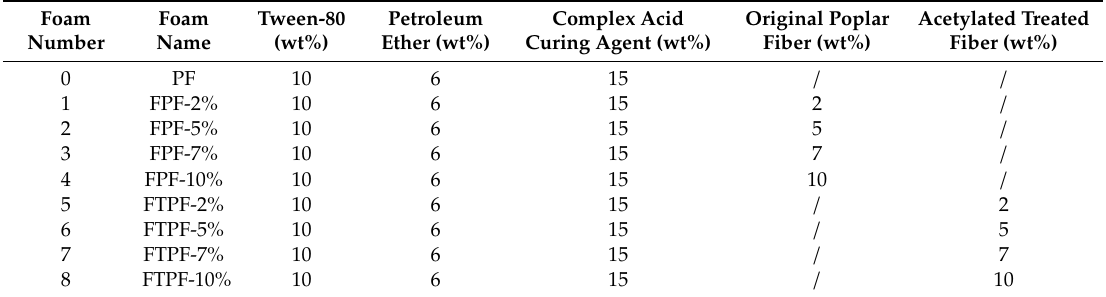
Table 1. Formulations of phenolic foam